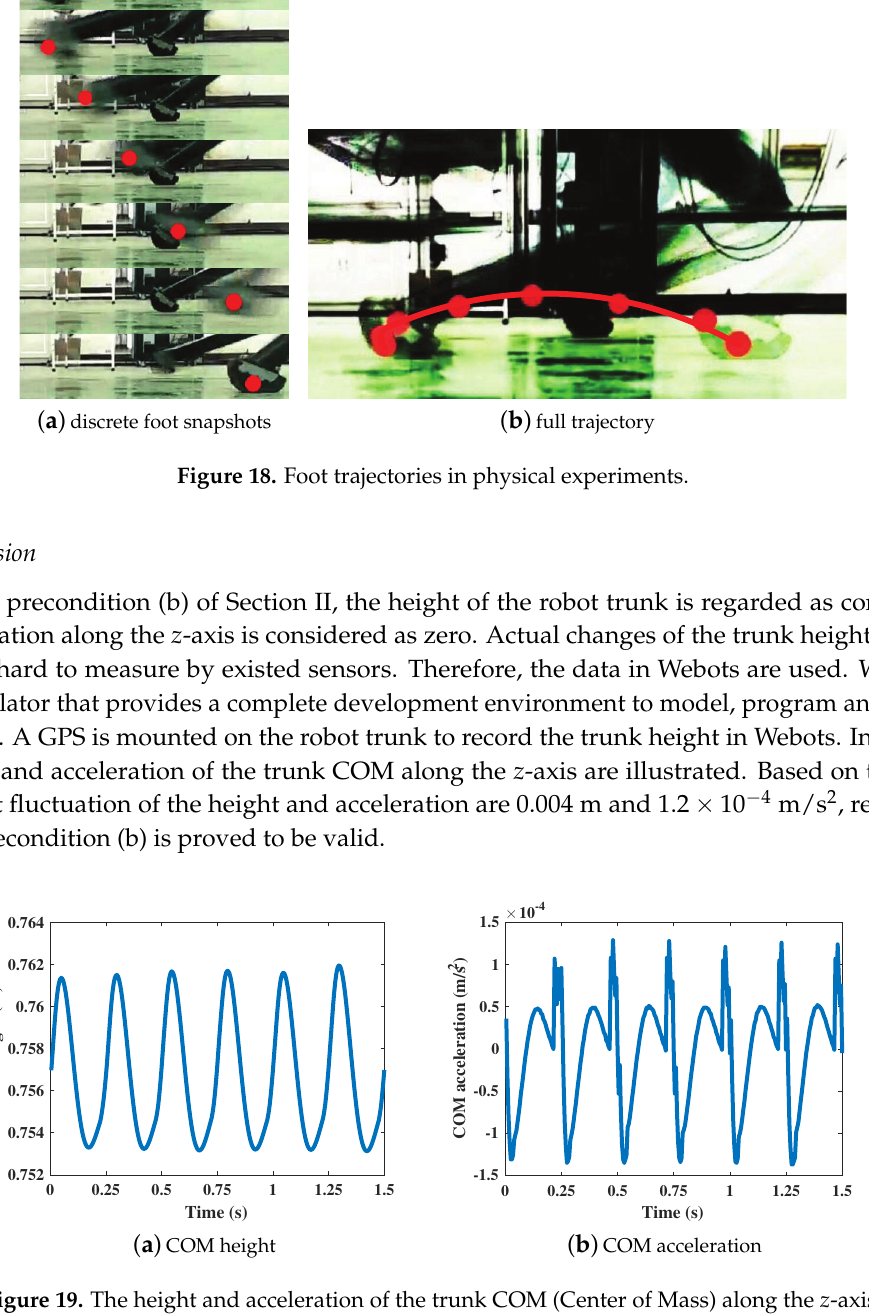
Figure 19. The height and acceleration of the trunk COM (Center of Mass) along the z